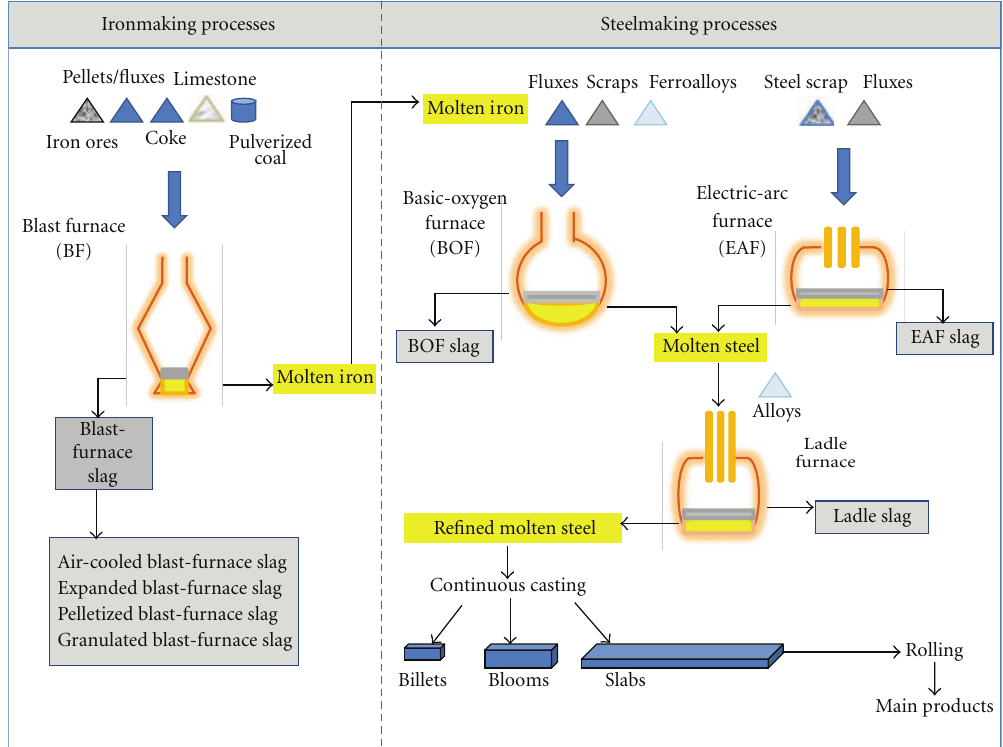
Figure 1: Flowchart of iron and steelmaking processes [1, 2].